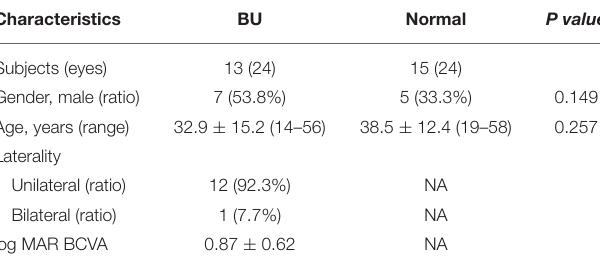
TABLE 1 | Characteristics of BU Patients and Normal Controls. TABLE 2 | Comparison of FAZ Parameters, Flow Area and Vascular Densities between BU and Normal